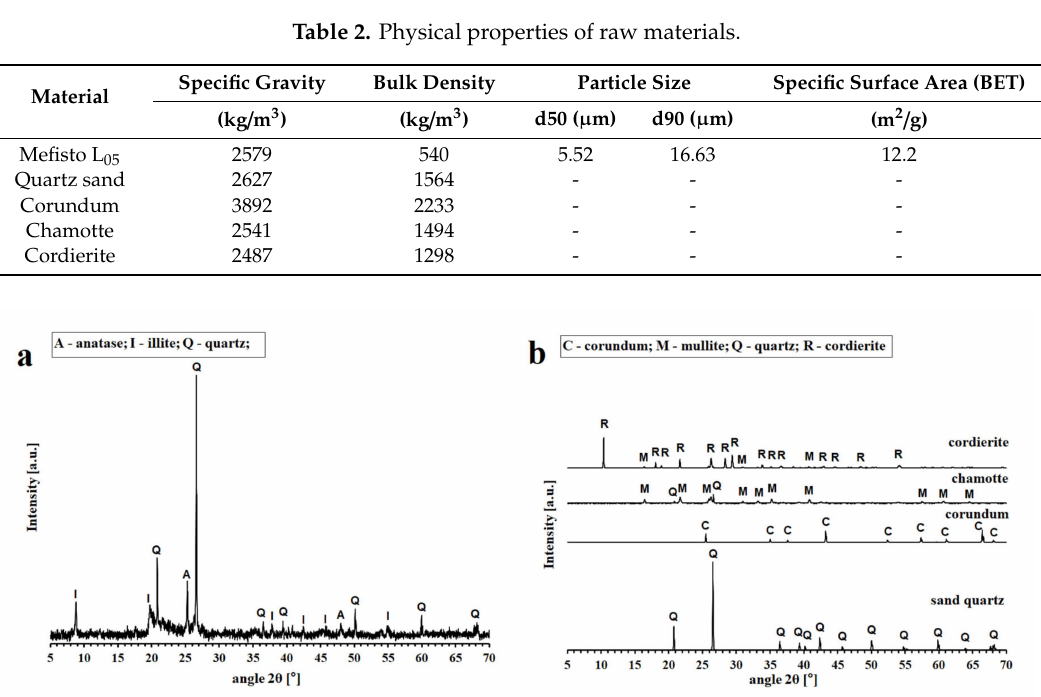
Figure 1. XRD patterns of the aluminosilicate Mefisto L 05 ( a ) and fillers ( b